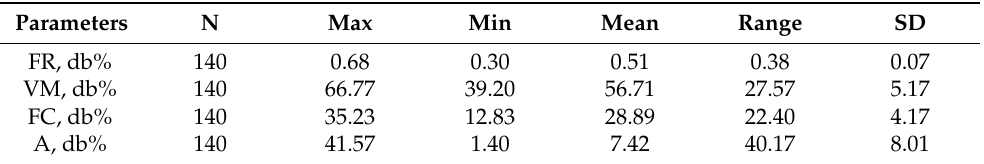
Figure 5. The ( a ) fuel ratio (FR, db%), ( b ) volatile matter (VM, db%), ( c ) fixed carbon (FC, db%), and ( d ) ash content (A, db%) of the 11 varieties of biomass pellets. Table 1. The statistical data of fuel ratio (FR), volatile matter (VM), fixed carbon (FC), and ash (A) of all biomass types obtained by a TGA